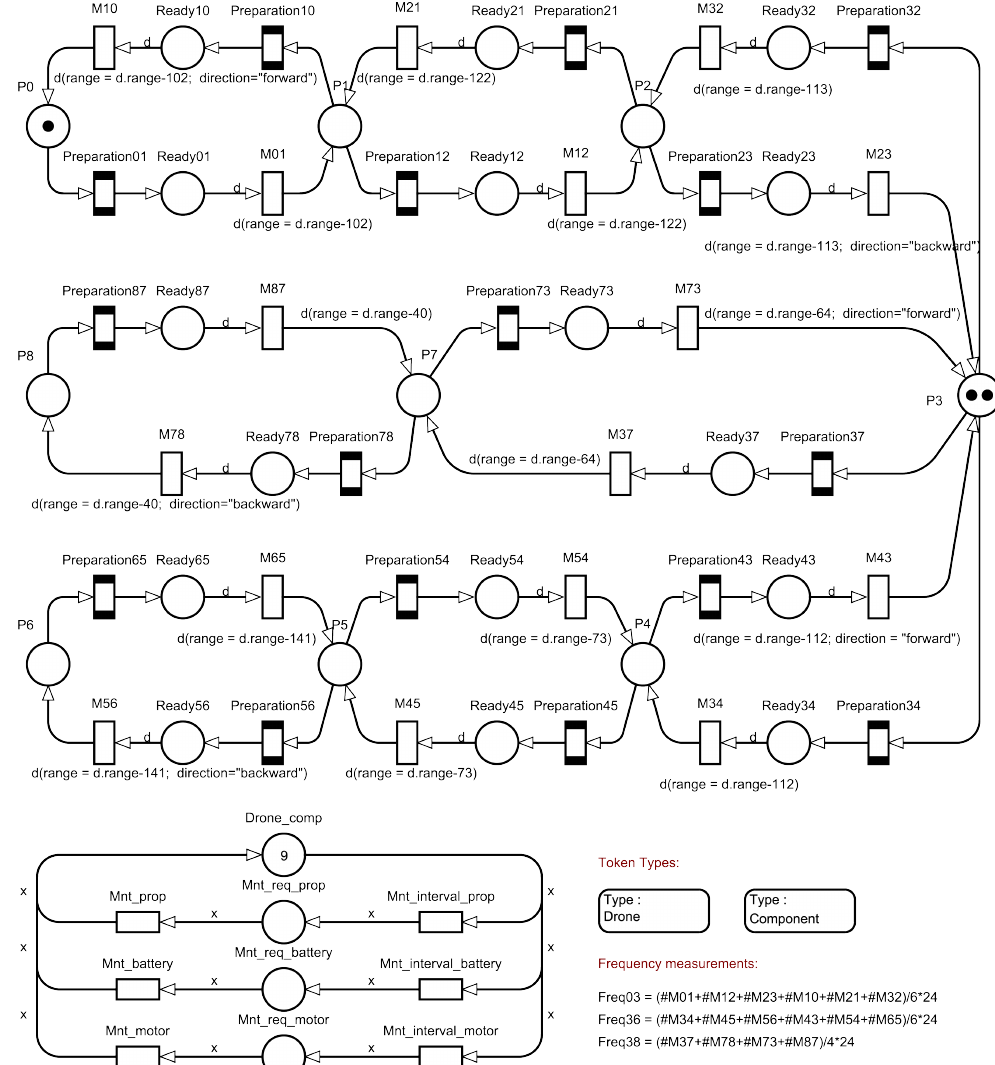
Figure 6. A scheme of the model implemented in TimeNET based on the oil pipeline